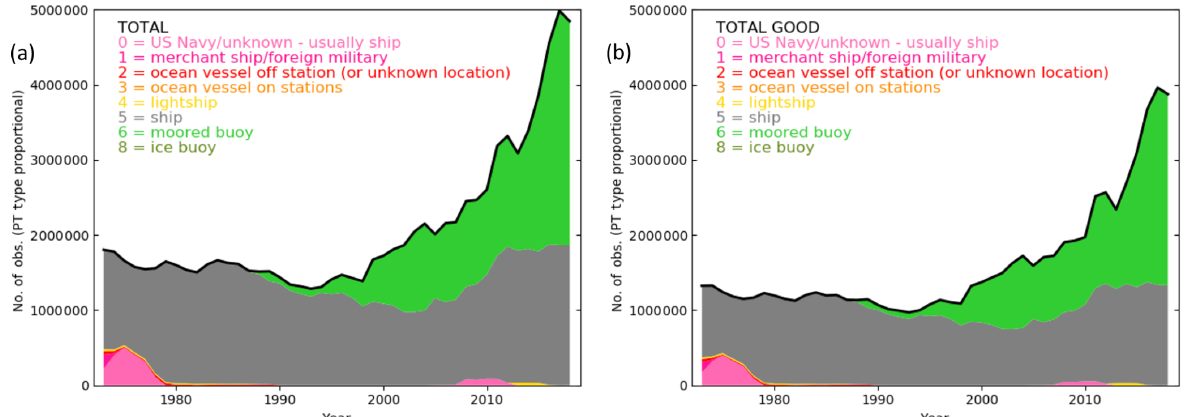
Figure 6. Annual observation count for the initial selection (a) and only those observations passing the final third-iteration quality control (b) , broken down by platform type (PT).